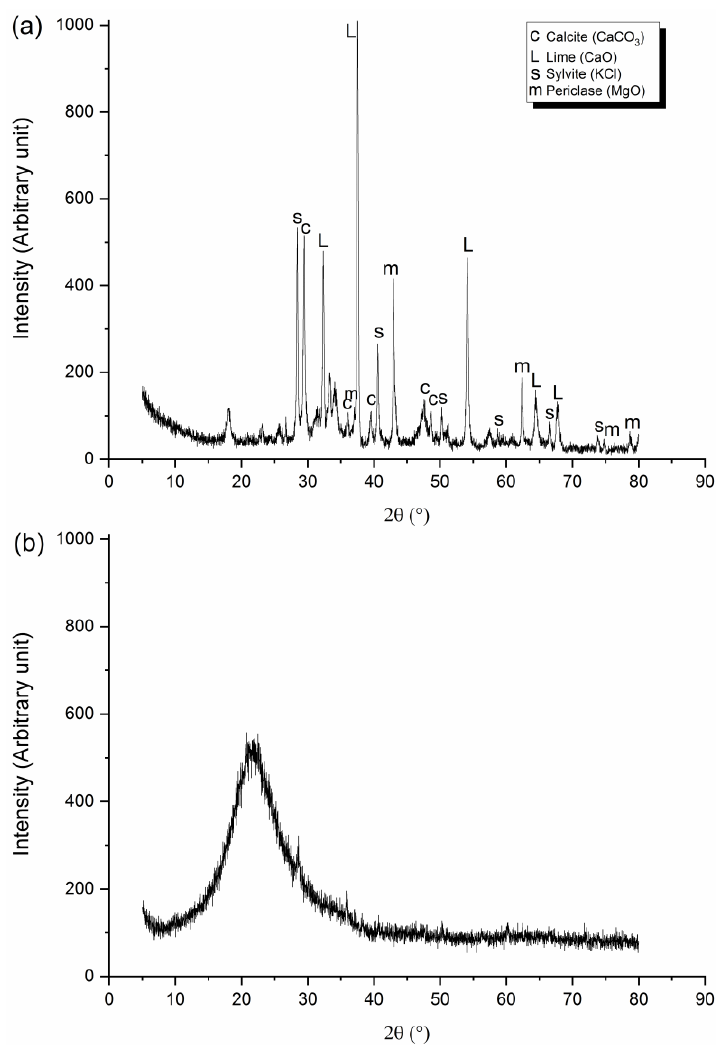
Figure 2. XRD of ( a ) EBA and ( b ) SF.